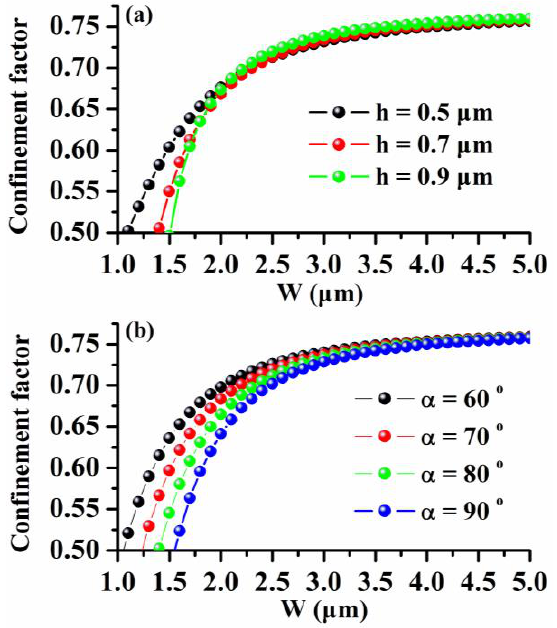
Figure 5. Confinement factor of the TE 00 mode in the rib waveguide as a function of rib width W in the two cases where ( a ) rib height h = 0.5, 0.7 and 0.9 µ m (the other parameters are α = 78.5 ◦ , H = 1 µ m and λ = 3.3 µ m) and ( b ) inclination angle α = 60 ◦ , 70 ◦ , 80 ◦ and 90 ◦ (the other input parameters are H = 1 µ m, h = 0.7 µ m and λ = 3.3 µ